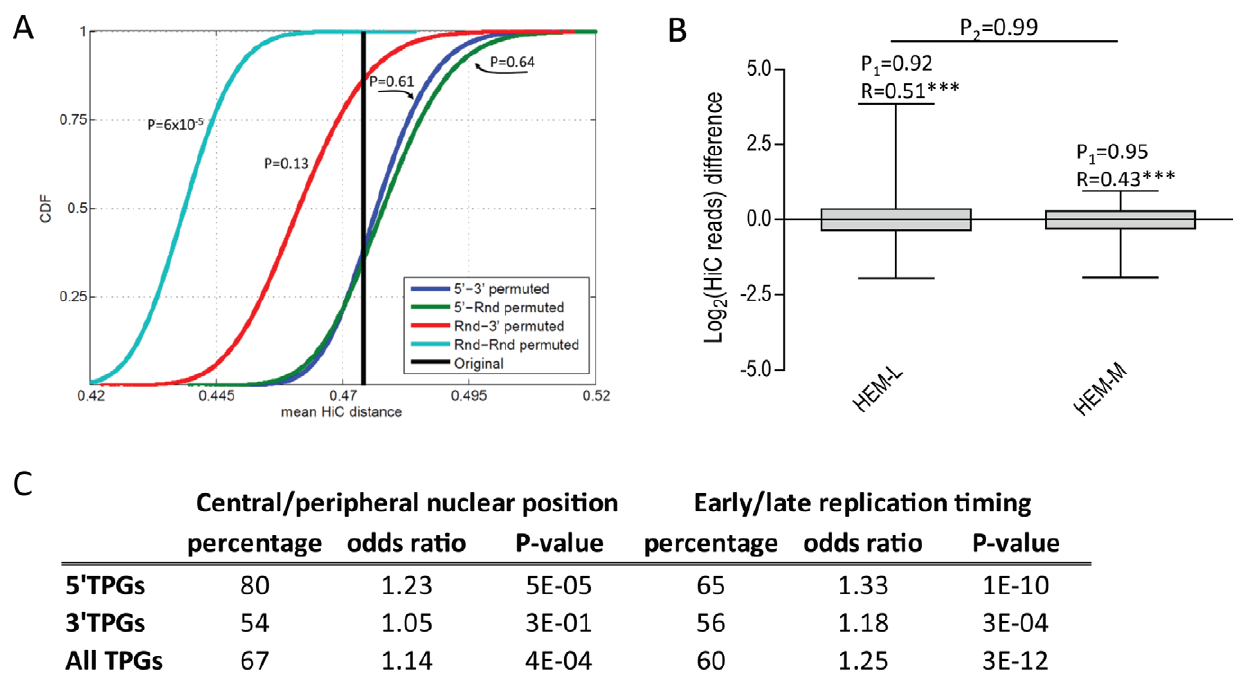
Figure 9. Spatial positioning and replication timing of TPGs. A: Mean pairwise Hi-C distance distributions (for n=239 TPG pairs) obtained using various permutation schemes (N=10 5 permutations); black line: original TPG pairs; blue: 5 9 and 3 9 TPGs randomly shuffled; red and dark green: either 5 9 or 3 9 TPGs replaced by random Refseq genes (Rnd); light green: random Refseq genes of the same size chosen arbitrarily as 5 9 or 3 9 TPG. Computed P-values for mean Hi-C distance of the original TPG set against permuted distributions are shown in the plot. B: Spatial closeness of TPG loci from translocations reported in tumors of lymphoid (HEM-L) and myeloid (HEM-M) origin, computed based on Hi-C data for GM06990 (of lymphoid origin) and K562 (of myeloid origin) cell lines. Difference between log2(Hi-C reads) of GM06990 value and K562 value is shown (higher value means closeness in GM06990 compared to K562). Wilcoxon matched ranks test P-values (P 1 ) and Spearman correlation coefficients (R) computed based on pairwise comparisons of distances for each translocation in HEM-L and HEM-M set. Correlation of Hi-C data between two cell lines is highly significant (***, P , 0.001, T-test). Hi-C closeness differences are statistically the same for HEM-L and HEM-M (P 2 , Mann-Whitney test). C: TPG frequency in central (proximal) and early replicating genomic loci, based on Hi-C and RT data respectively. Percentage of TPGs in central (early) genomic loci and odds ratios of these percentage compared to background set (all RefSeq genes) are presented. P-values computed based on binomial distribution. territories [18]. Furthermore, the RT of a chromosomal region is associated with mutation rate [19] and somatic copy number alterations are often bounded by early replicating regions [20]. We grouped smoothed RT data for GM06990 cell line into early and late replicating regions based on distribution of all RefSeq genes (supplementary Figure S6) and analyzed RT values of TPG- containing regions. As shown in Figure 9C and supplementary Figure S6B, both 5 9 TPGs and 3 9 TPGs are significantly over- represented in early-replicating regions. Likewise, TPGs are replicated significantly earlier than all RefSeq genes based on raw RT values for their genomic regions (supplementary Figure S6D), with 5 9 and 3 9 TPGs having similar timing. To further strengthen this observation, we repeated our analysis on more samples from the ReplicationDomain database. The results obtained for hematological samples were in good agreement with GM06990 cell line, while non-hematological samples only show slight trends (supplementary Figure S6C).